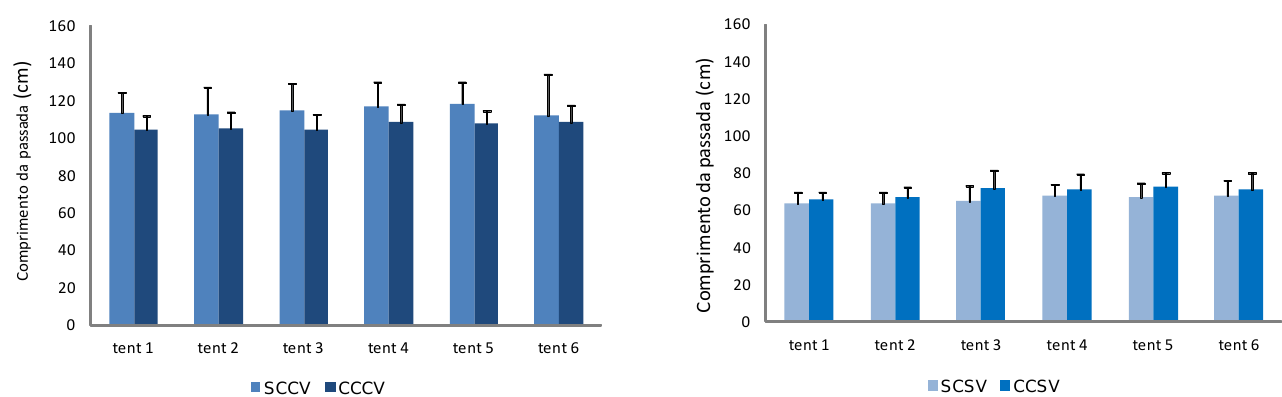
Figura 5. Média e desvio-padrão do comprimento das passadas nas condições experimentais com e sem o cão, mas com uso da visão (lado esquerdo) e com e sem o cão, mas sem o uso da visão (lado direito).